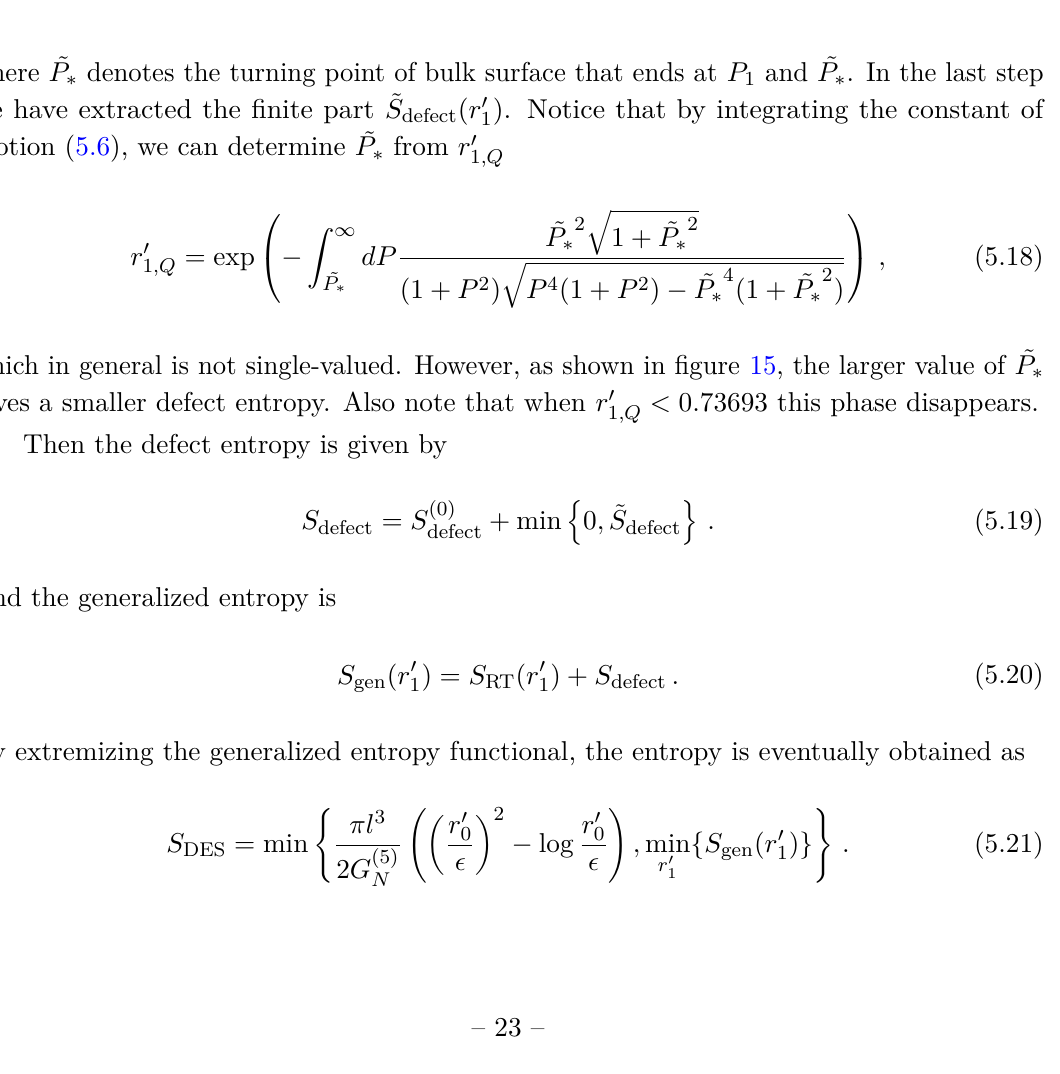
with respect to r 0 . The arrows denote the increasing 1 ,Q G (5) N